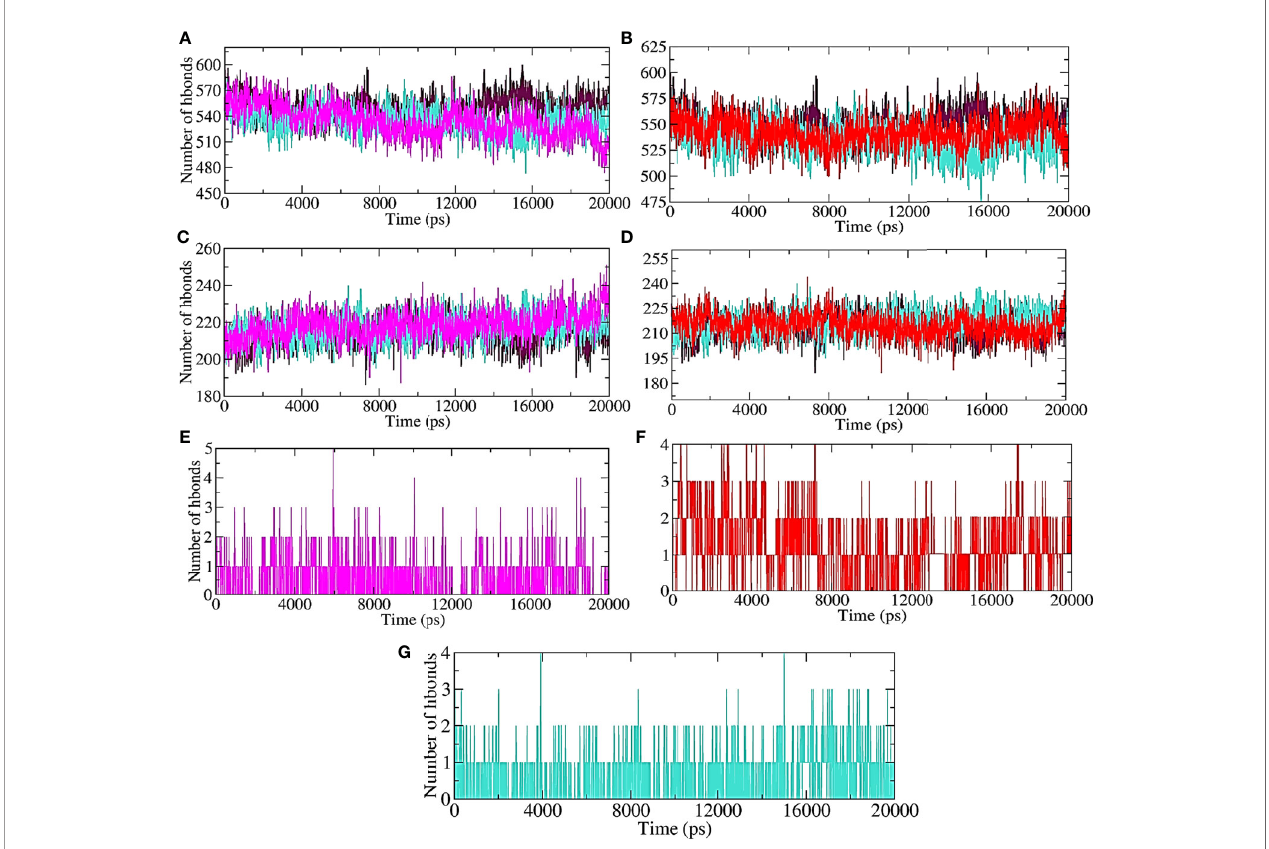
FIGURE 7 | Plot of hydrogen bond formation during the MD simulation period of M pro protein in ligand-bound and unbound conformation. Hydrogen bond formation between water and test protein in unbound, lopinavir-bound, (A) Aloe vera lead compound 10-Hydroxyaloin A – bound, and (B) Neem lead compound Isoquercetin- bound complexes. Intraprotein hydrogen bond formation in unbound, lopinavir – bound, (C) Aloe vera lead compound 10-Hydroxyaloin A – bound, and (D) Neem lead compound Isoquercetin-bound complexes. Hydrogen bond formation between M pro complexed with (E) Aloe vera lead compound 10-Hydroxyaloin A, (F) Neem lead compound Isoquercetin, and (G) Lopinavir. Unbound protein, black color; Aloe vera – bound complex, pink; Neem-bound complex, red; and Lopinavir-bound complex is shown in light-blue